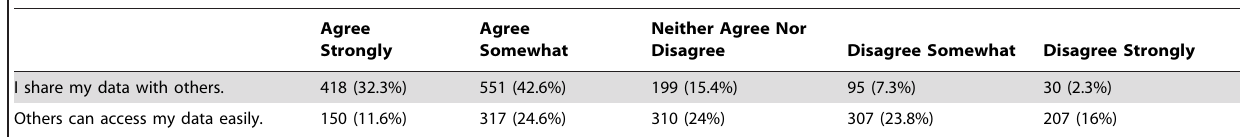
Table 11. Data sharing.